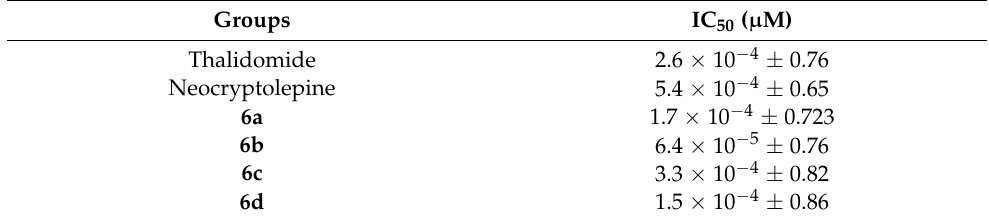
Table 1. In vitro cytotoxic activities of indoloquinoline analogs 6a–d versus the reference drug, thalidomide and the parent natural compound,